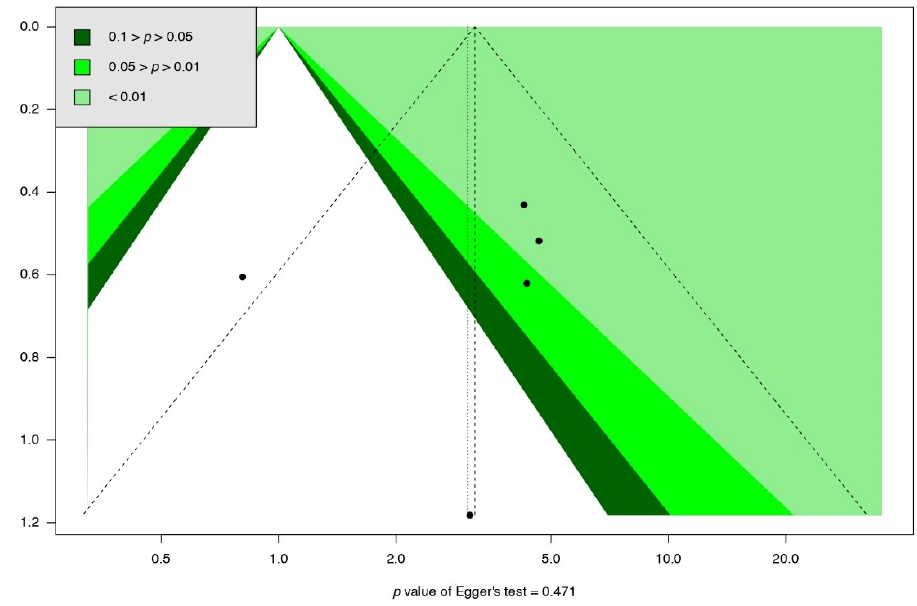
Figure A38. Comparison-adjusted funnel plot in outcome for final stone free rate.